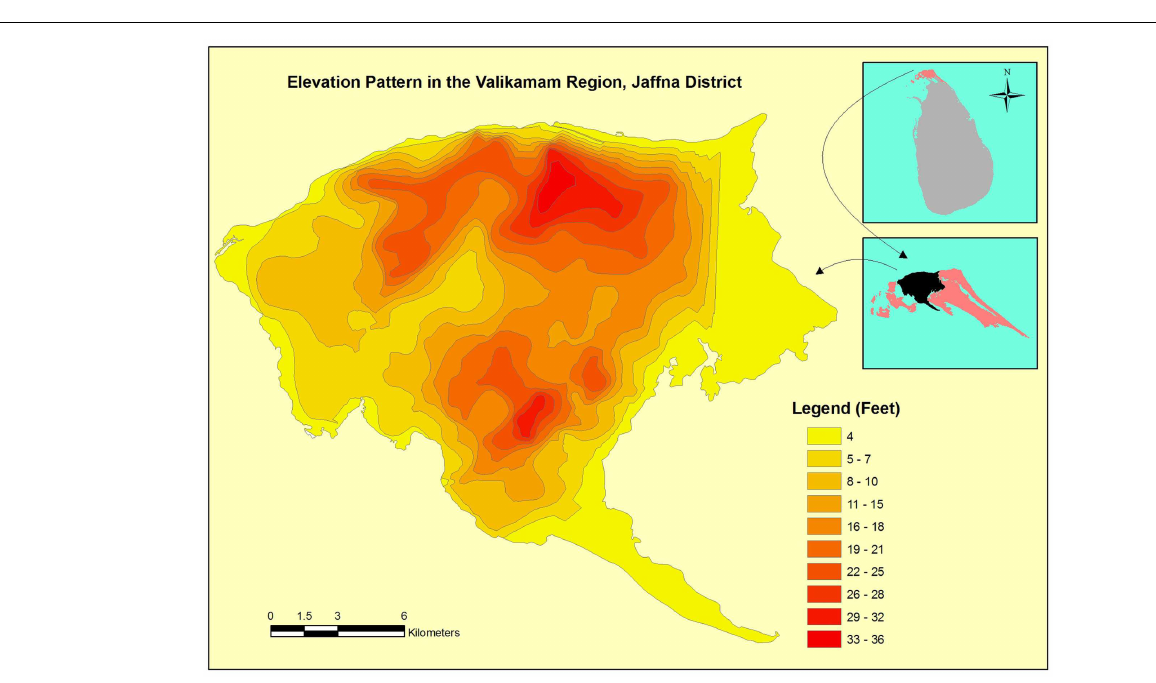
FIGURE 7 | Map showing elevations above mean sea level in theValikamam division of the Jaffna